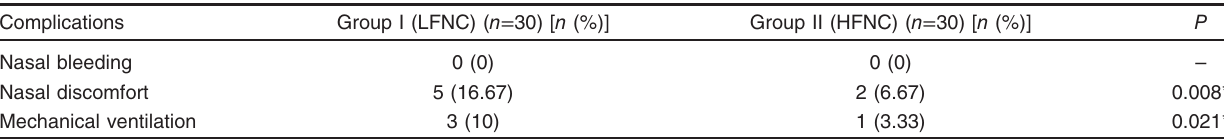
Table 8 Complication of the study in both groups